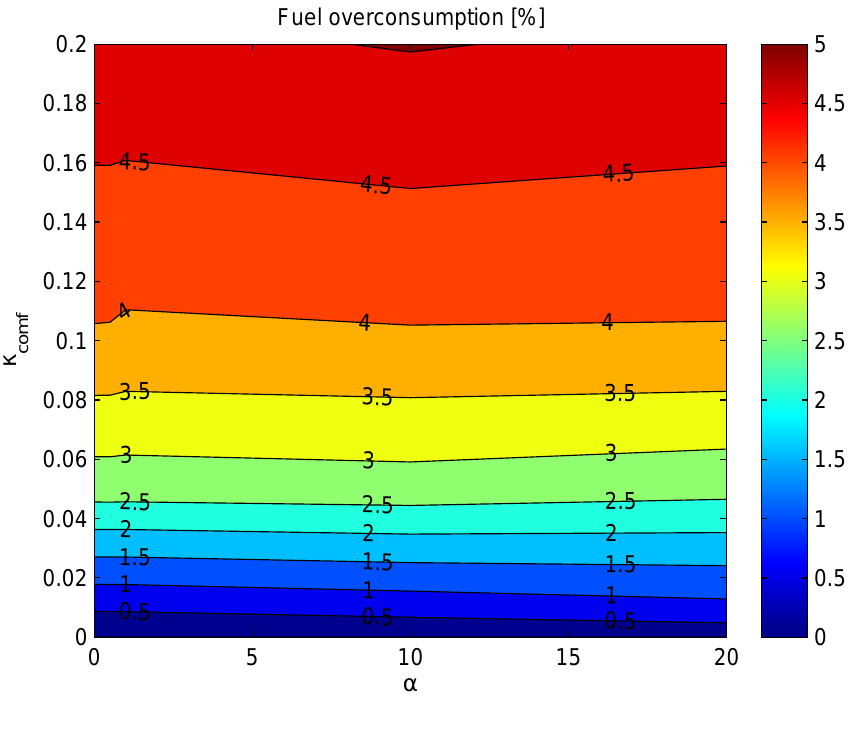
on the fuel overconsumption variation, relative (%) to comf = 0 (reference comf